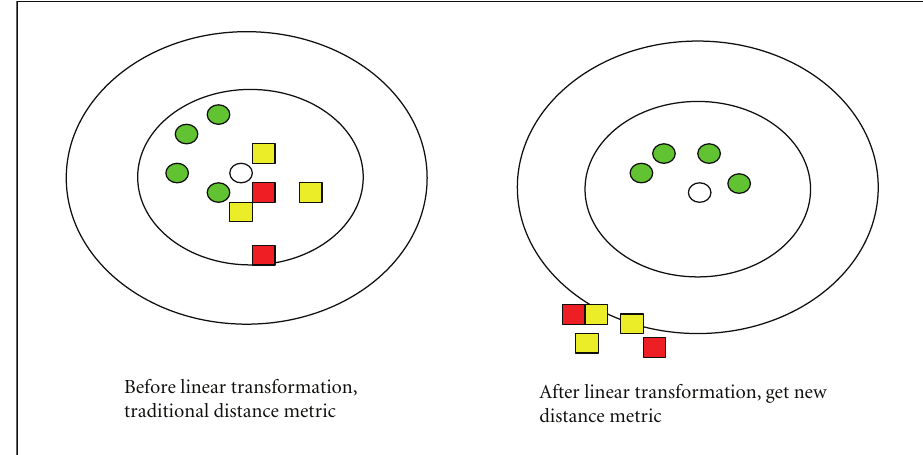
Figure 1: An example of